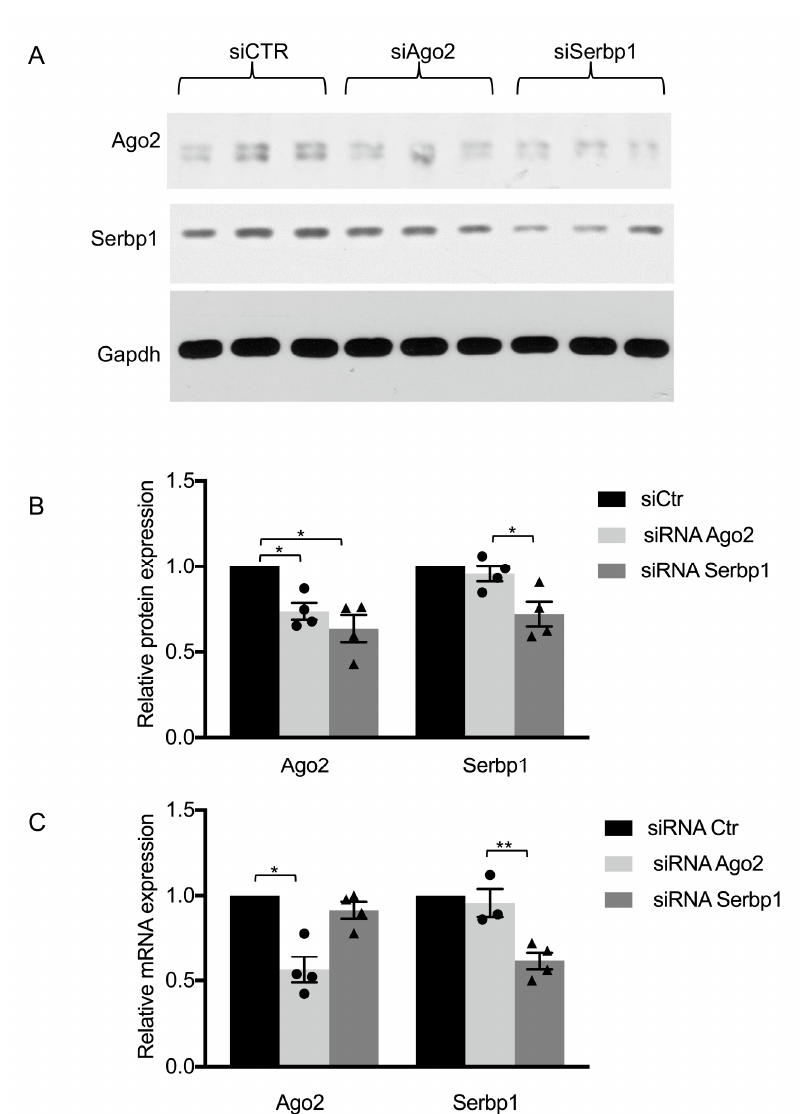
Figure 2. SERBP1-silencing downregulates Ago2 protein levels in SH-SY5Y cells. ( A ) Representative Western blot of extracts from cells transfected with control siRNA, Ago2 siRNA or SERBP1 siRNA from three independent experiments. Nitrocellulose membranes were hybridized with Ago2 or SERBP1 antibodies, as indicated. The GAPDH signal was used to normalize different samples ( B ). Fold change of Ago2 and SERBP1 protein levels in siRNA transfected cells relative to control siRNA samples are shown. Data represent the mean of three independent experiments ± standard error (S.E.); * p < 0.05 ( t -test).. ( C ) RT-qPCR analysis of RNA extracted from SH-SY5Y cells transfected with control siRNA, Ago2 siRNA or SERBP1 siRNA. ∆ Ct values were normalized to TBP level. Fold change of Ago2 and Serbp1 mRNA expression levels relative to control siRNA samples are shown. Individual data points for Ago2 (circles) and Serbp1 (triangles) siRNA transfected cells are indicated. Data represent the mean of three independent experiments ± S.E.; * p < 0.05, ** p <